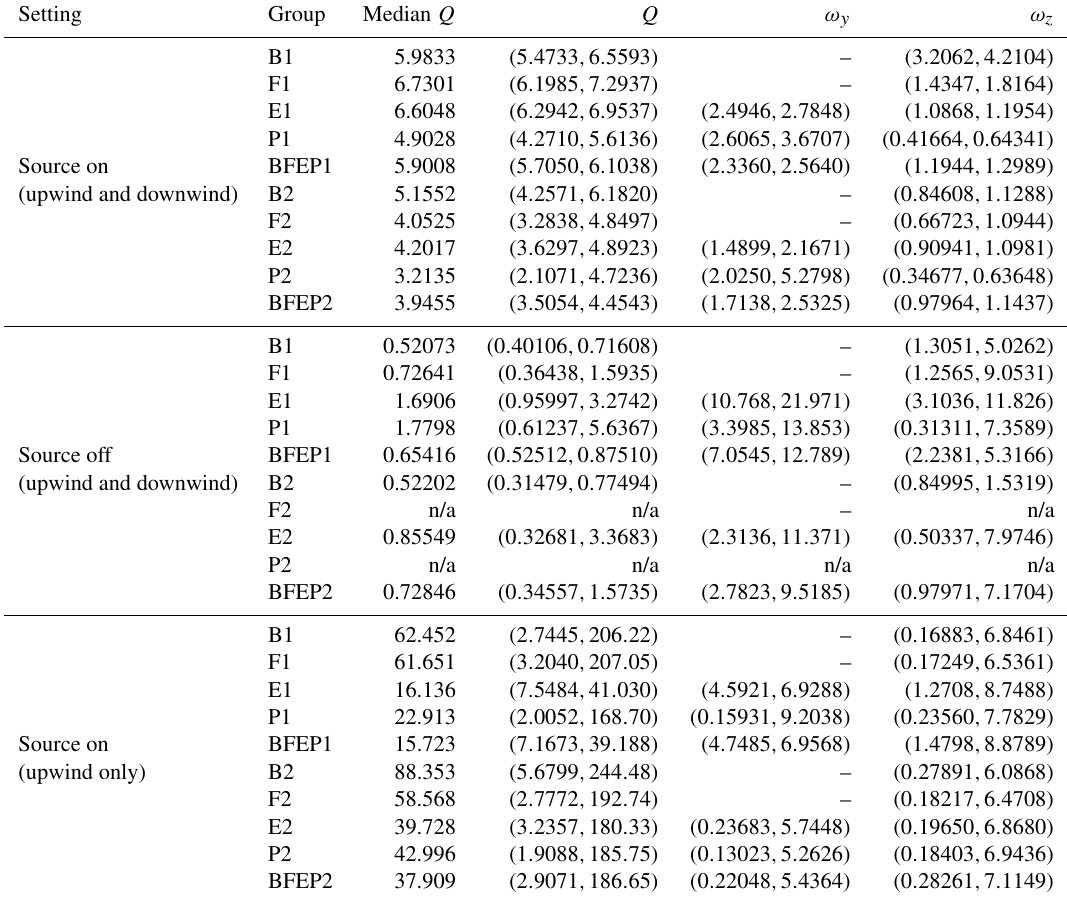
Table A1. Posterior median emission rate in grams per minute (gmin − 1 ), and the posterior 95% credible intervals for the emission rate in grams per minute, ω y , and ω z , for the Boreal lasers (B), FTIR spectrometers (F), EC towers (E), Picarro analysers (P), and an ensemble of all instruments (BFEP), for each release-rate period (5.8gmin − 1 (1), and 5.0gmin − 1 (2)) under various settings. Dashes correspond